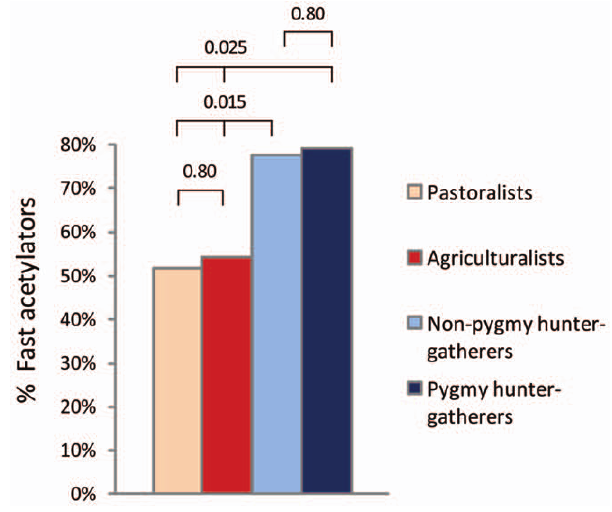
Figure 5. Kruskal-Wallis test for equality of frequency of the fast acetylation phenotype across subsistence modes, by distinguishing between Pygmy and non-Pygmy hunter-gath- erers. Statistical significance ( P -value) is reported above the graph.